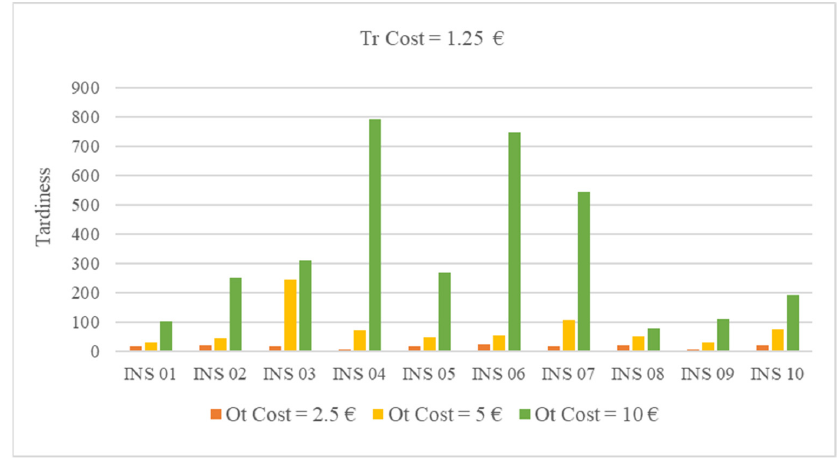
Figure 7. The amount of imposed “Tardiness” with respect to various overtime penalties.